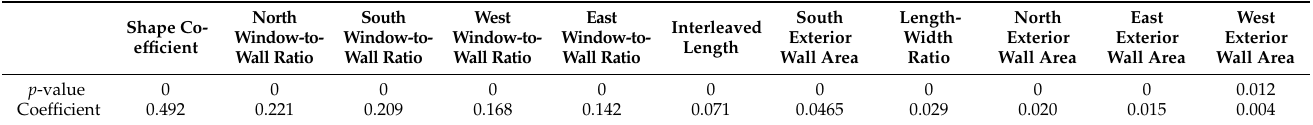
Table 7. Standard regression coefficient of each parameter after standard regression.